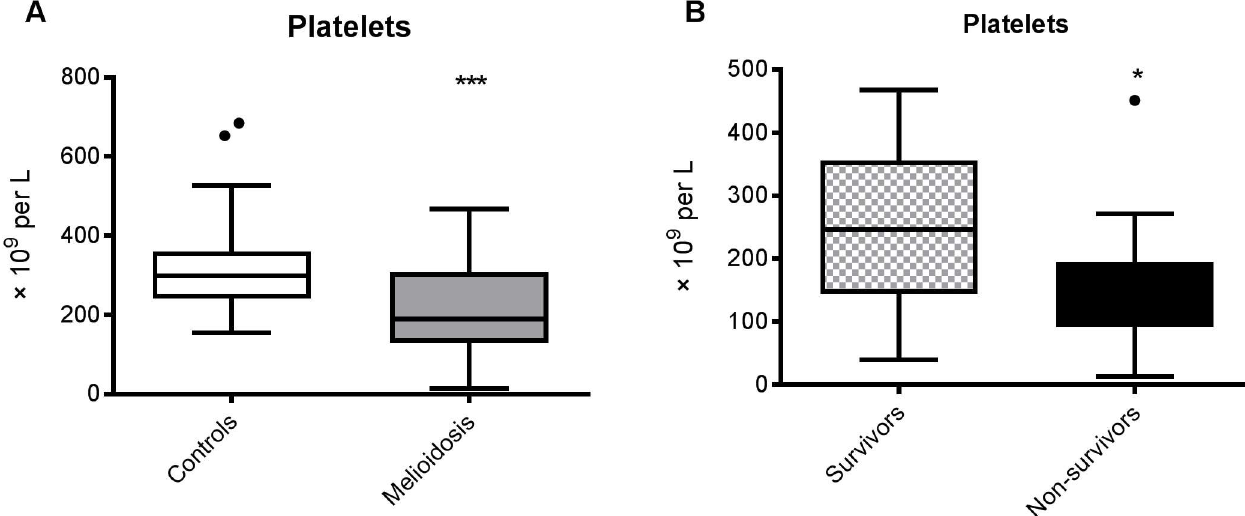
Fig 1. Thrombocytopenia is a feature of acute melioidosis (A) and correlateswith mortality (B). The data from 34 melioidosis patients (of whom 12 died) and 52 controls are presentedas box plots with Tukey whiskersshowingthe smallest observation, lower quartile, median,upper quartileand largest observation. *** P < 0.001for the difference betweenpatients and controls; * P < 0.05 for the difference betweensurvivors (n = 22) and non-survivors (n = 12) (Student’s t-test).